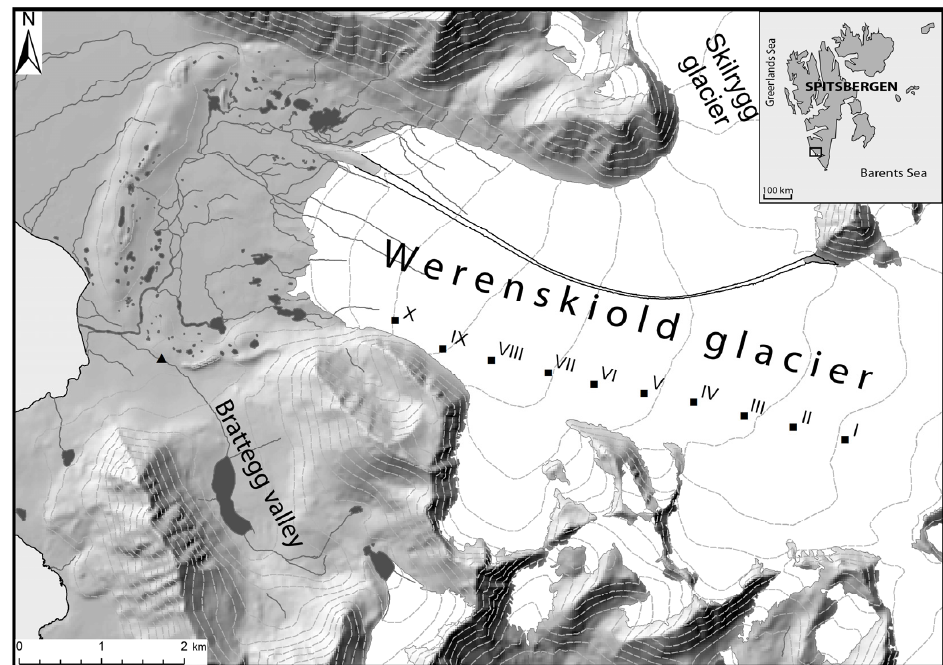
Figure 1. Geographic location of the Werenskiold Glacier on Spitsbergen (Svalbard Archipelago, Arctic) and study sites from I to X.